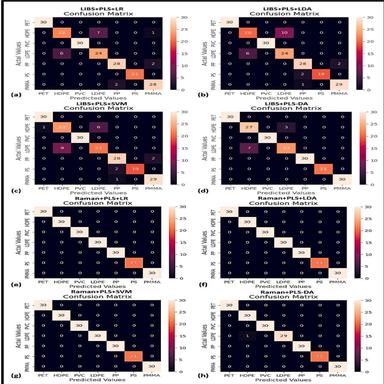
Confusion matrix for different classifiers coupled to PLS output on LIBS and Raman spectra of plastics.